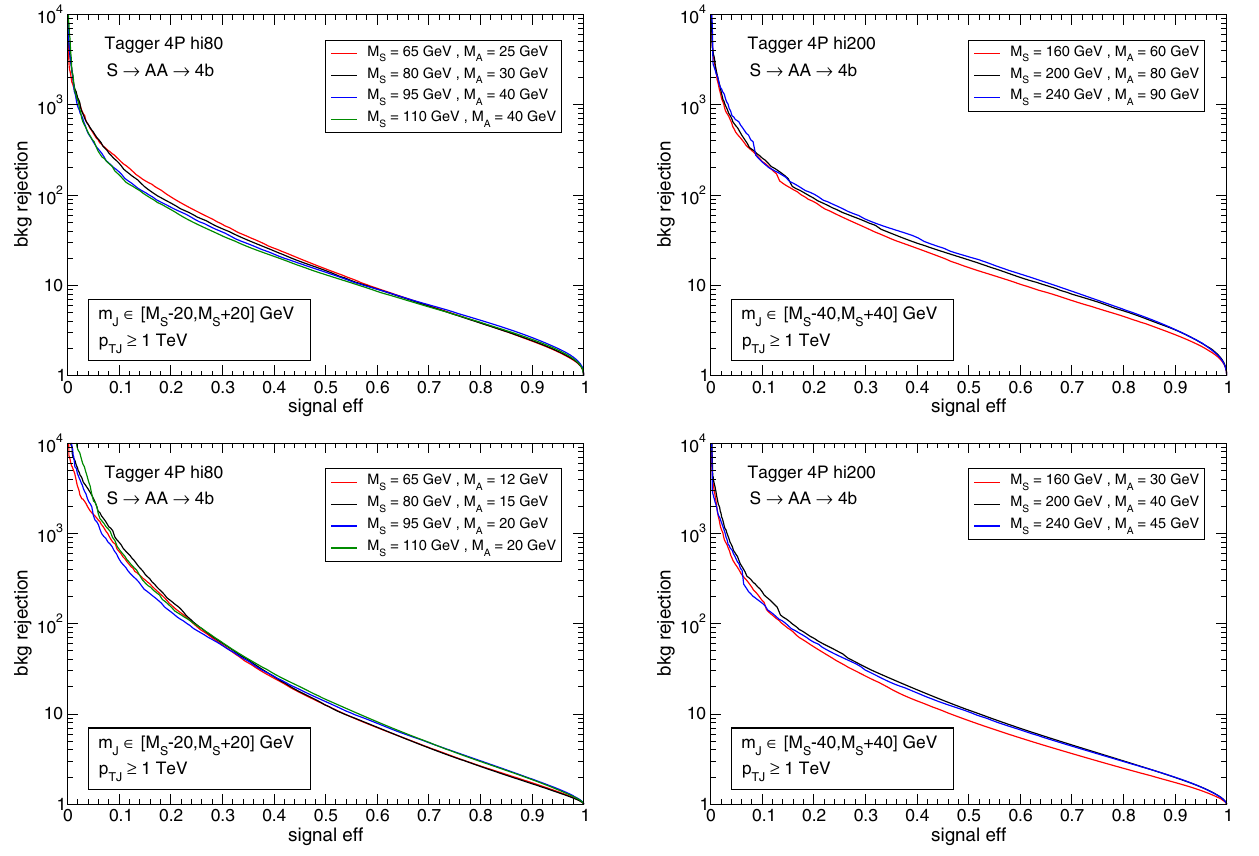
Fig. 5 ROC curves for the hi80 (left) and hi200 (right) T 4 P taggers applied to S → AA → 4 b signals of different masses, see the